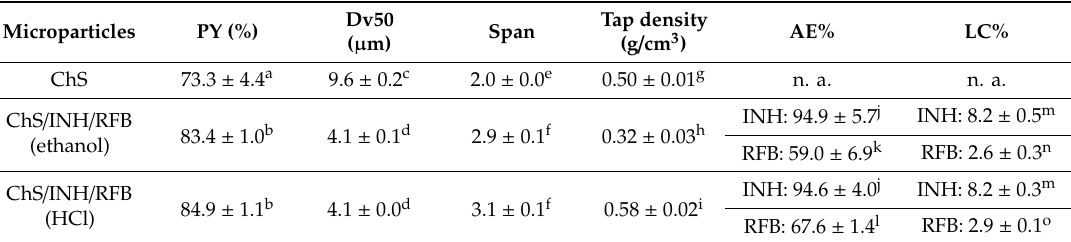
Table 2. Production yield (PY), median volume particle size (Dv50), tap density, drug association e ffi ciency (AE) and loading capacity (LC) of ChS microparticles (mean ± SD, n = 3). Di ff erent letters indicate statistically significant di ff erence within the same parameter ( p < 0.05).